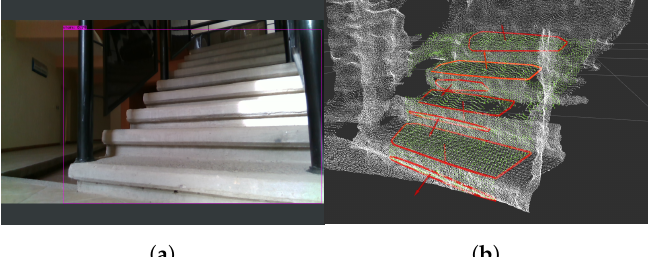
Figure 9. Results obtained using the D435i camera pipeline: ( a ) staircase detection, ( b ) smooth region